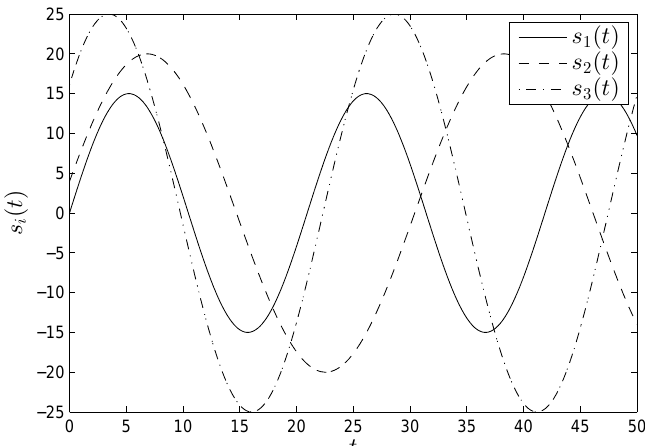
Figure 6. The original messages s i ( t ) to be transmitted by n transmit antennas in a MIMO secure communication